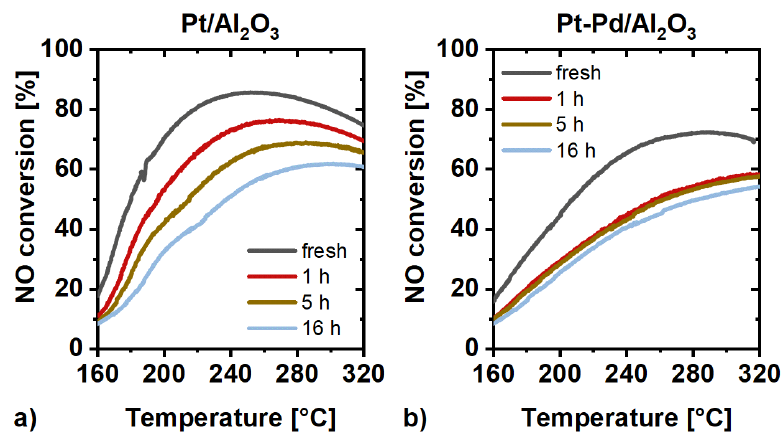
Figure A3. Temperature of 50% conversion (T 50 ) of CO during light off tests in 800 ppm CO, 7% CO 2 , 5% O 2 , 5% H 2 O, and bal. N 2 at a GHSV of 80 000 h − 1 of reduced ( a ) and oxidized ( b ) Pt/Al 2 O 3 , Pd/Al 2 O 3 , and Pt-Pd/Al 2 O 3 .